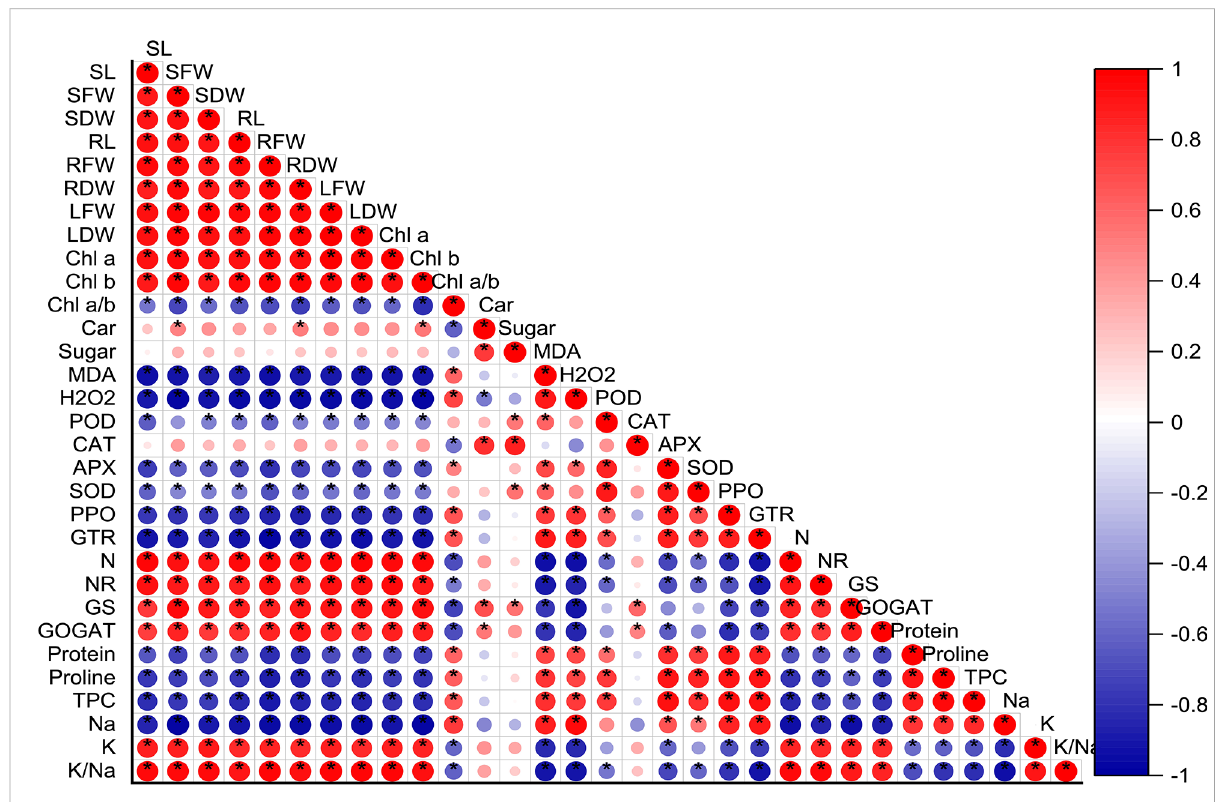
FIGURE 8 Correlation analysis between all the studied parameters. Red and blue color represent the positive and negative correlation. The size and intensity of color exhibited the signi fi cance of variables, and * represents the signi fi cance level at P <0.05. SL, stem length; SFW, stem fresh weight; SDW, stem dry weight; RL, root length, RFW, root fresh weight; RDW, root dry weight, LFW, Leaf fresh weight; LDW, leaf dry weight; Chl, chlorophyll; Car, carotenoids; MDA, malondialdehyde; H 2 O 2 , hydrogen peroxide; POD, peroxidase; CAT, catalase; APX, ascorbate peroxidase; SOD, superoxide dismutase; PPO, polyphenol oxidases; GTR, glutathione reductase; N, nitrogen; NR, nitrate reductase; GS, glutamine synthetase; GOGAT, glutamate synthase; TPC, total phenolic content; Na, sodium and K,